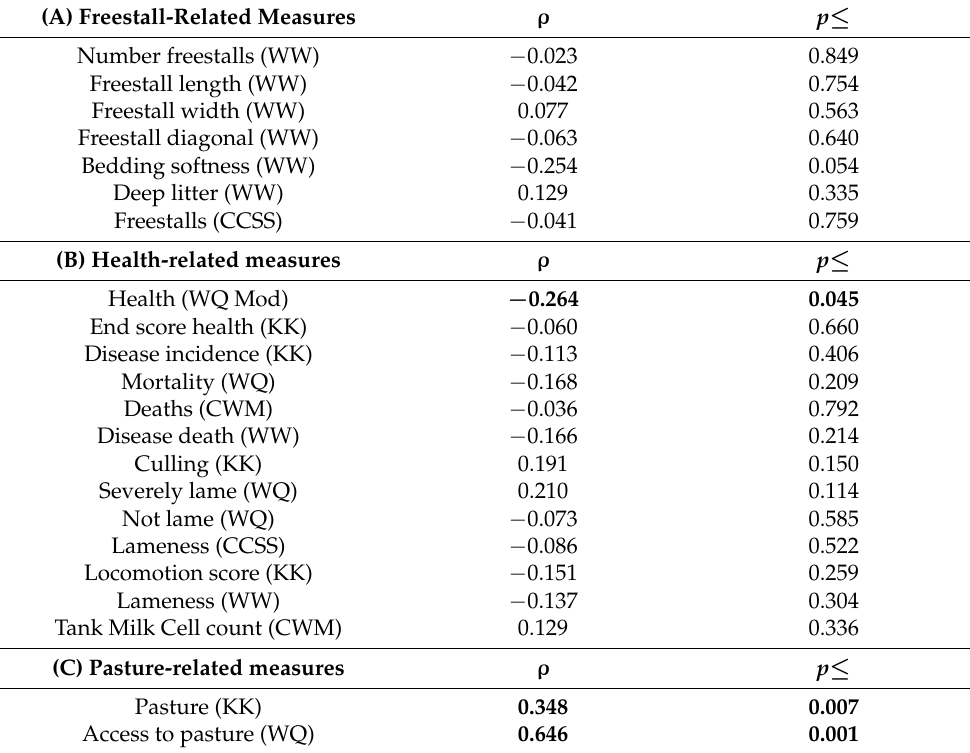
Table 4. Spearman rank correlations (Rho, ρ ) and associated probabilities ( p -values, printed bold if ≤ 0.05) between cortisol and (A) freestall-related measures, (B) several health-related parameters, taken from the different welfare assessment protocols, and (C) access to pasture, all at herd level. The welfare score are printed bold and